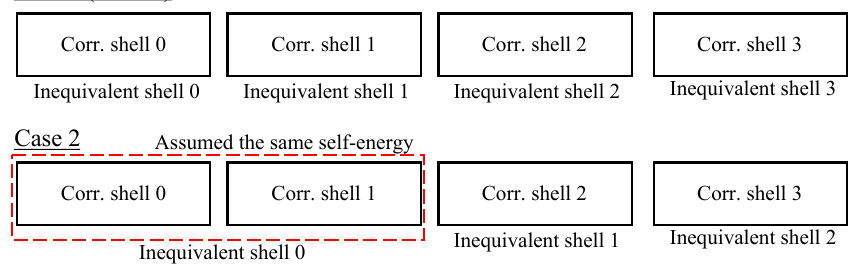
Figure 2: Correlated shells and inequivalent shells